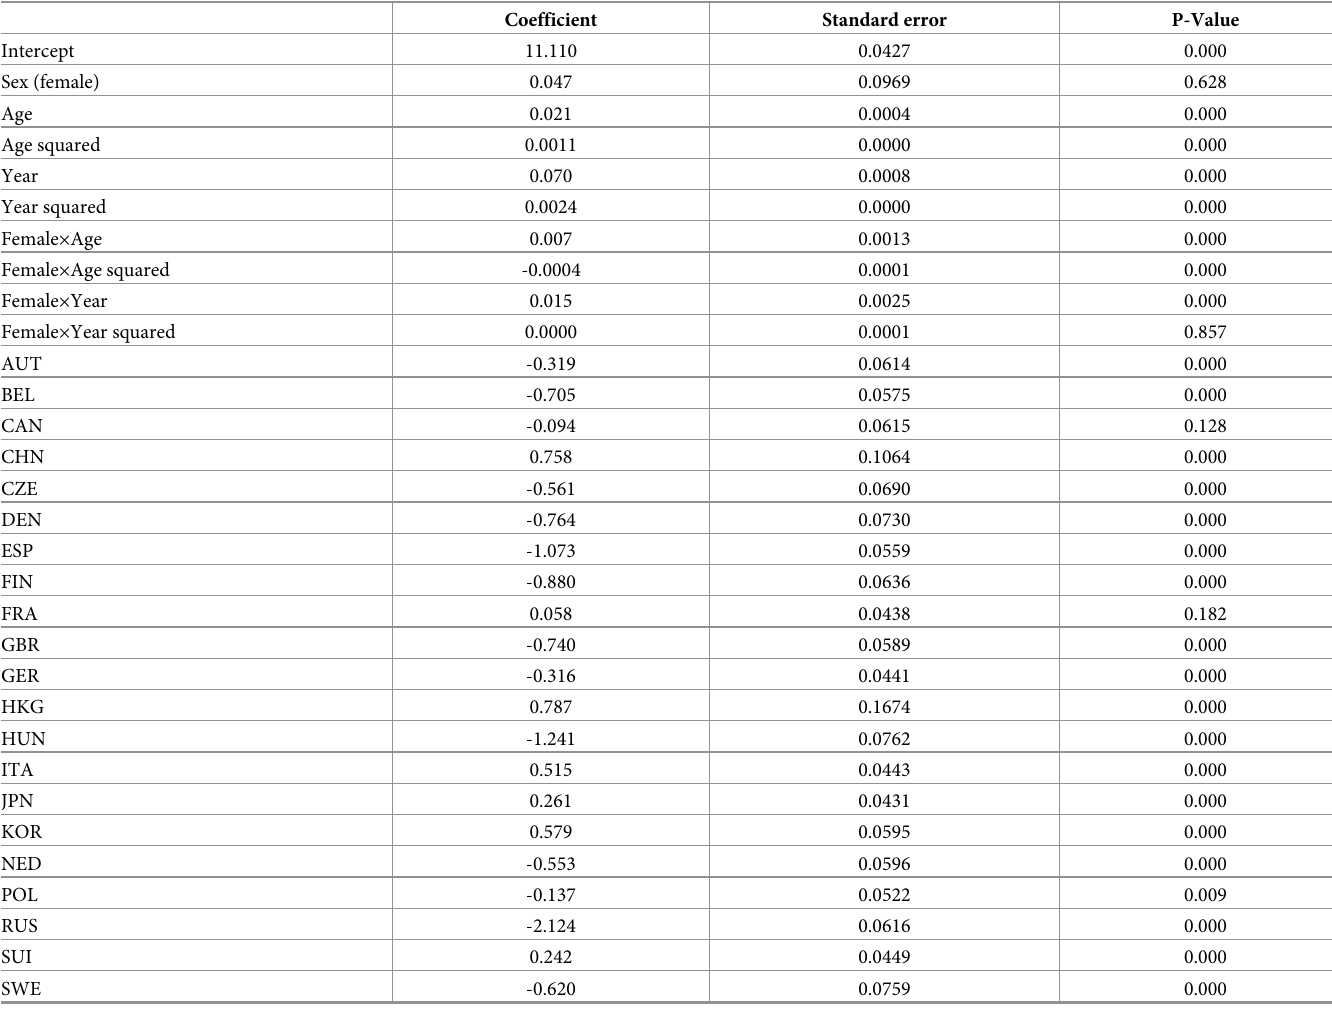
Table 11. Results from linear regression with truncated dataset time = sex × (year+year 2 )+sex × (age+age 2 )+sex × nationality and referenced to male, age 44, year 2009 and nationality Australia. R 2 =